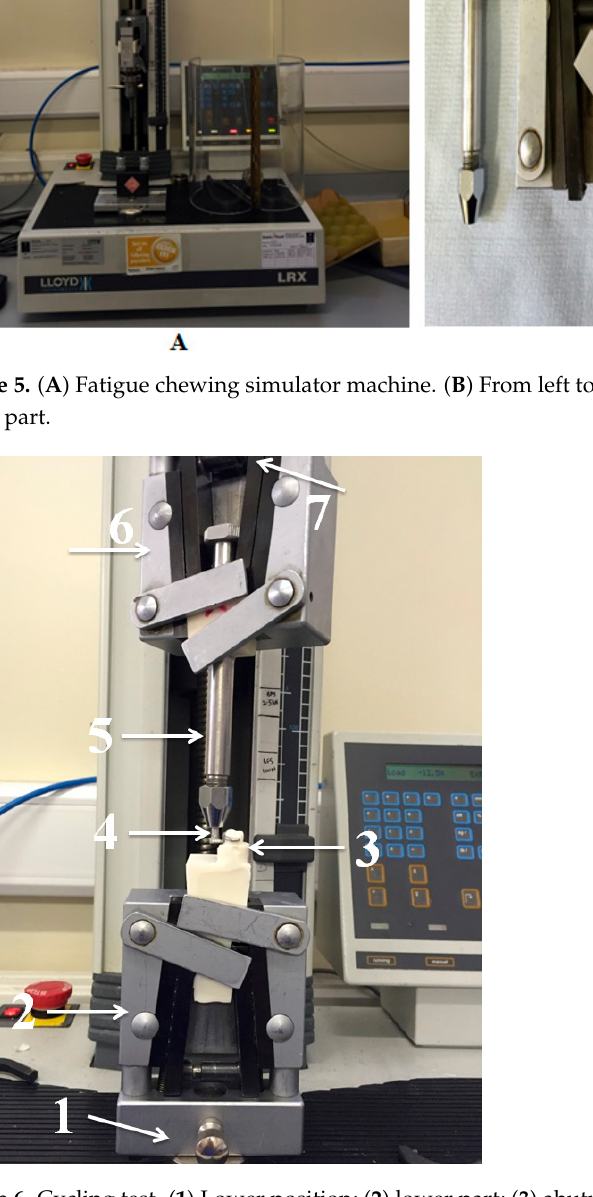
Figure 6 . Cycling test. ( 1 ) Lower position; ( 2 ) lower part; ( 3 ) abutment crown with holder; ( 4 ) clasp with holder; ( 5 ) metallic holder; ( 6 ) upper part; and ( 7 ) upper position. 2.7. Fitting Surface (Inner Surface) Deformation Analysis PEEK and Co-Cr clasps were evaluated under a cycling test simulating six months of use, using a fatigue chewing simulator machine tensile tester unit (2.5 KN Lloyd LRX). The test conditions were maintained at room temperature (20 ± 2 °C). During the